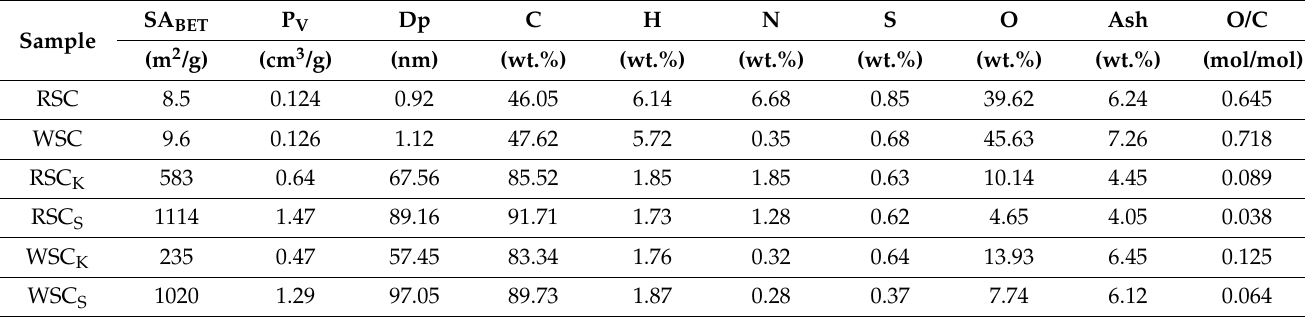
Table 1. The main characteristics of biochars and activated biochars prepared by carbonization at 650 ◦ C from rapeseed cake and walnut shells and activated by KOH and H 2 SO 4 at 800 ◦